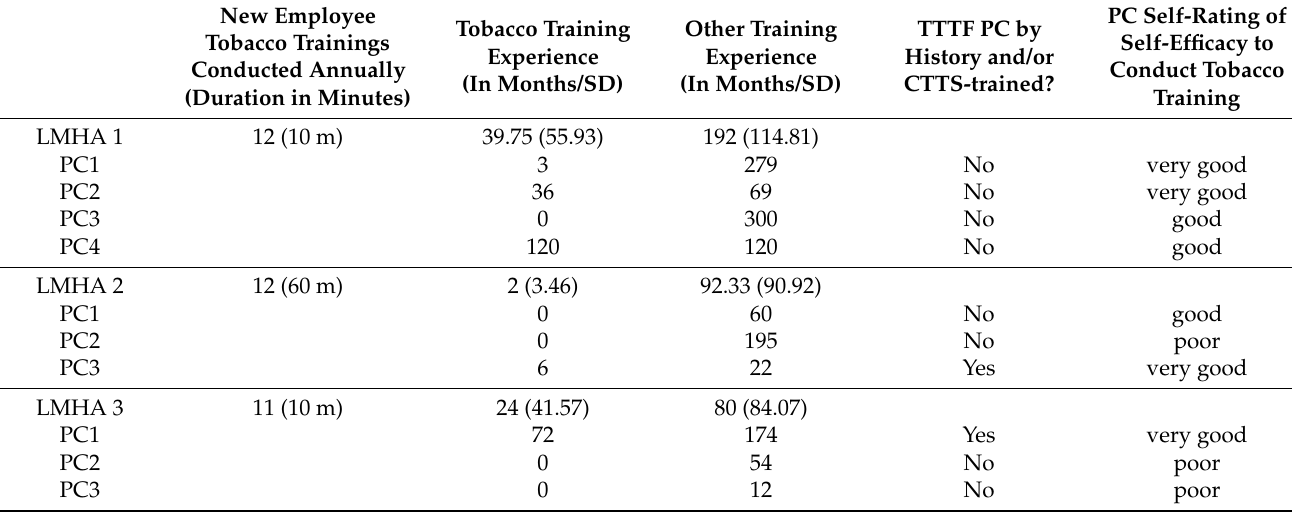
Table 1. Participating Local Mental Health Authorities and Champions’ Pre-Program Implementation Training